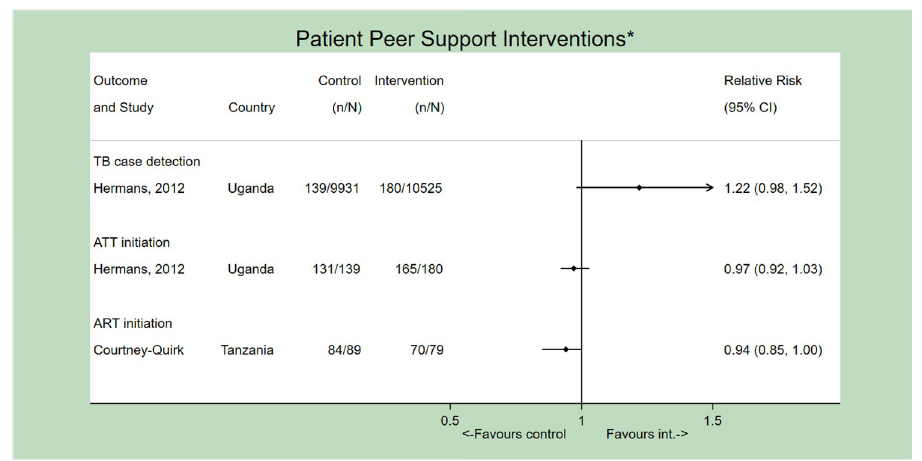
Fig 6. Forest plot (not pooled) depicting the effect of patient peer support interventions on all outcomes. � All studies implemented concurrent interventions and/or SOC strategies. Only the first author of each study is listed. ATT = Anti-tuberculosis